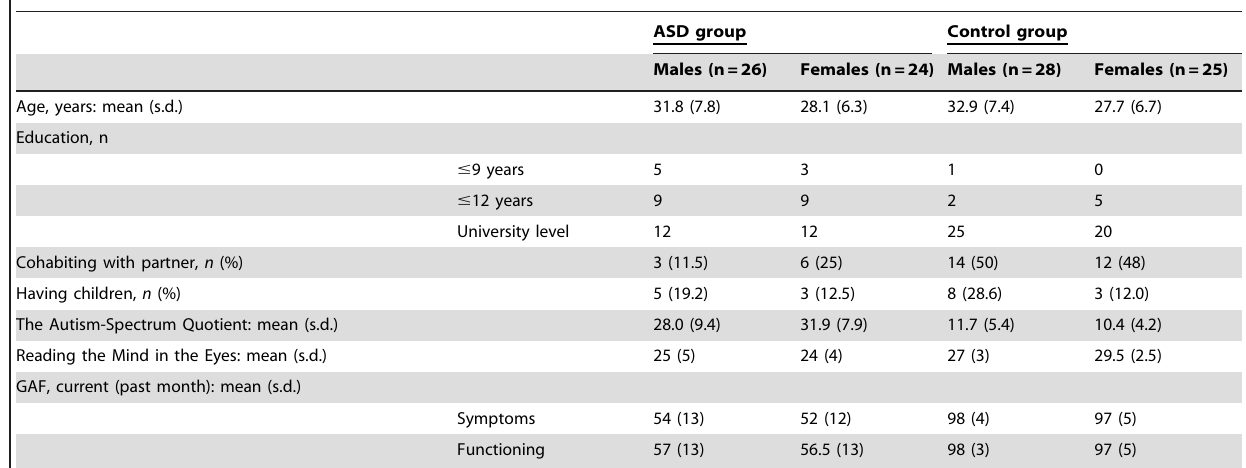
Table 1. Demographic data of the study samples.